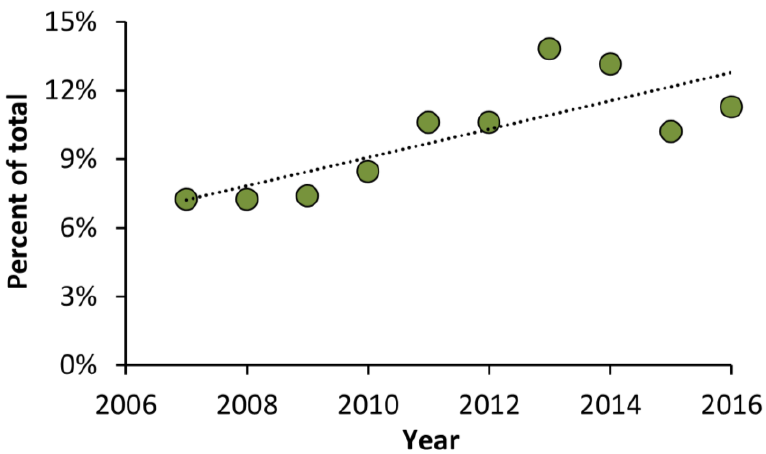
Figure 3. The number of rollator accidents increased between 2007–2016 (based on data from 10 hospital